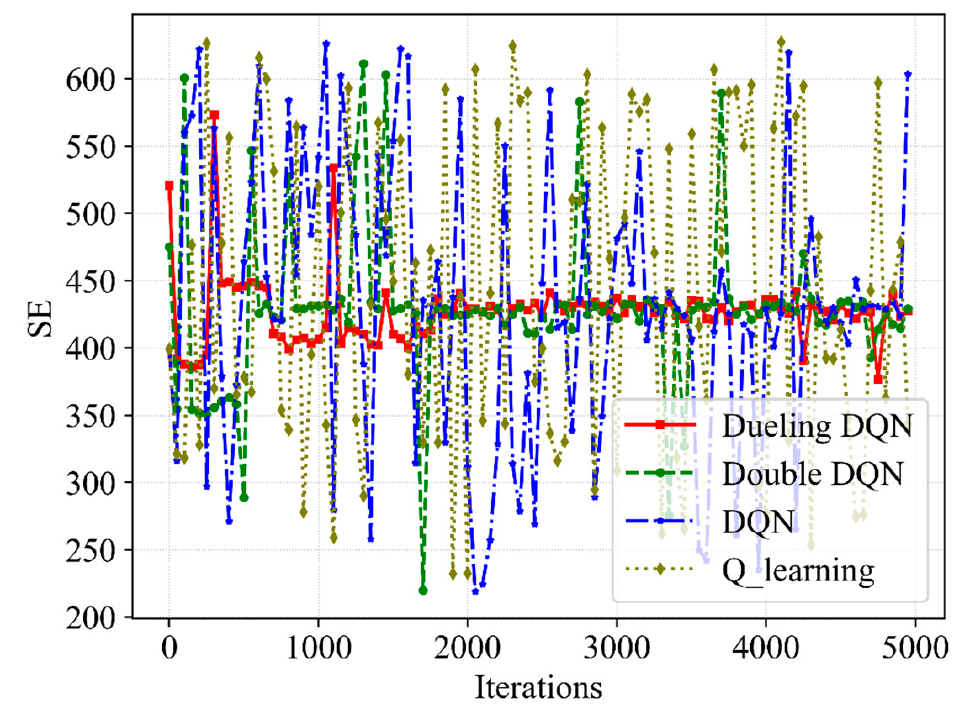
Sensors 2023 , 23 , x FOR PEER REVIEW